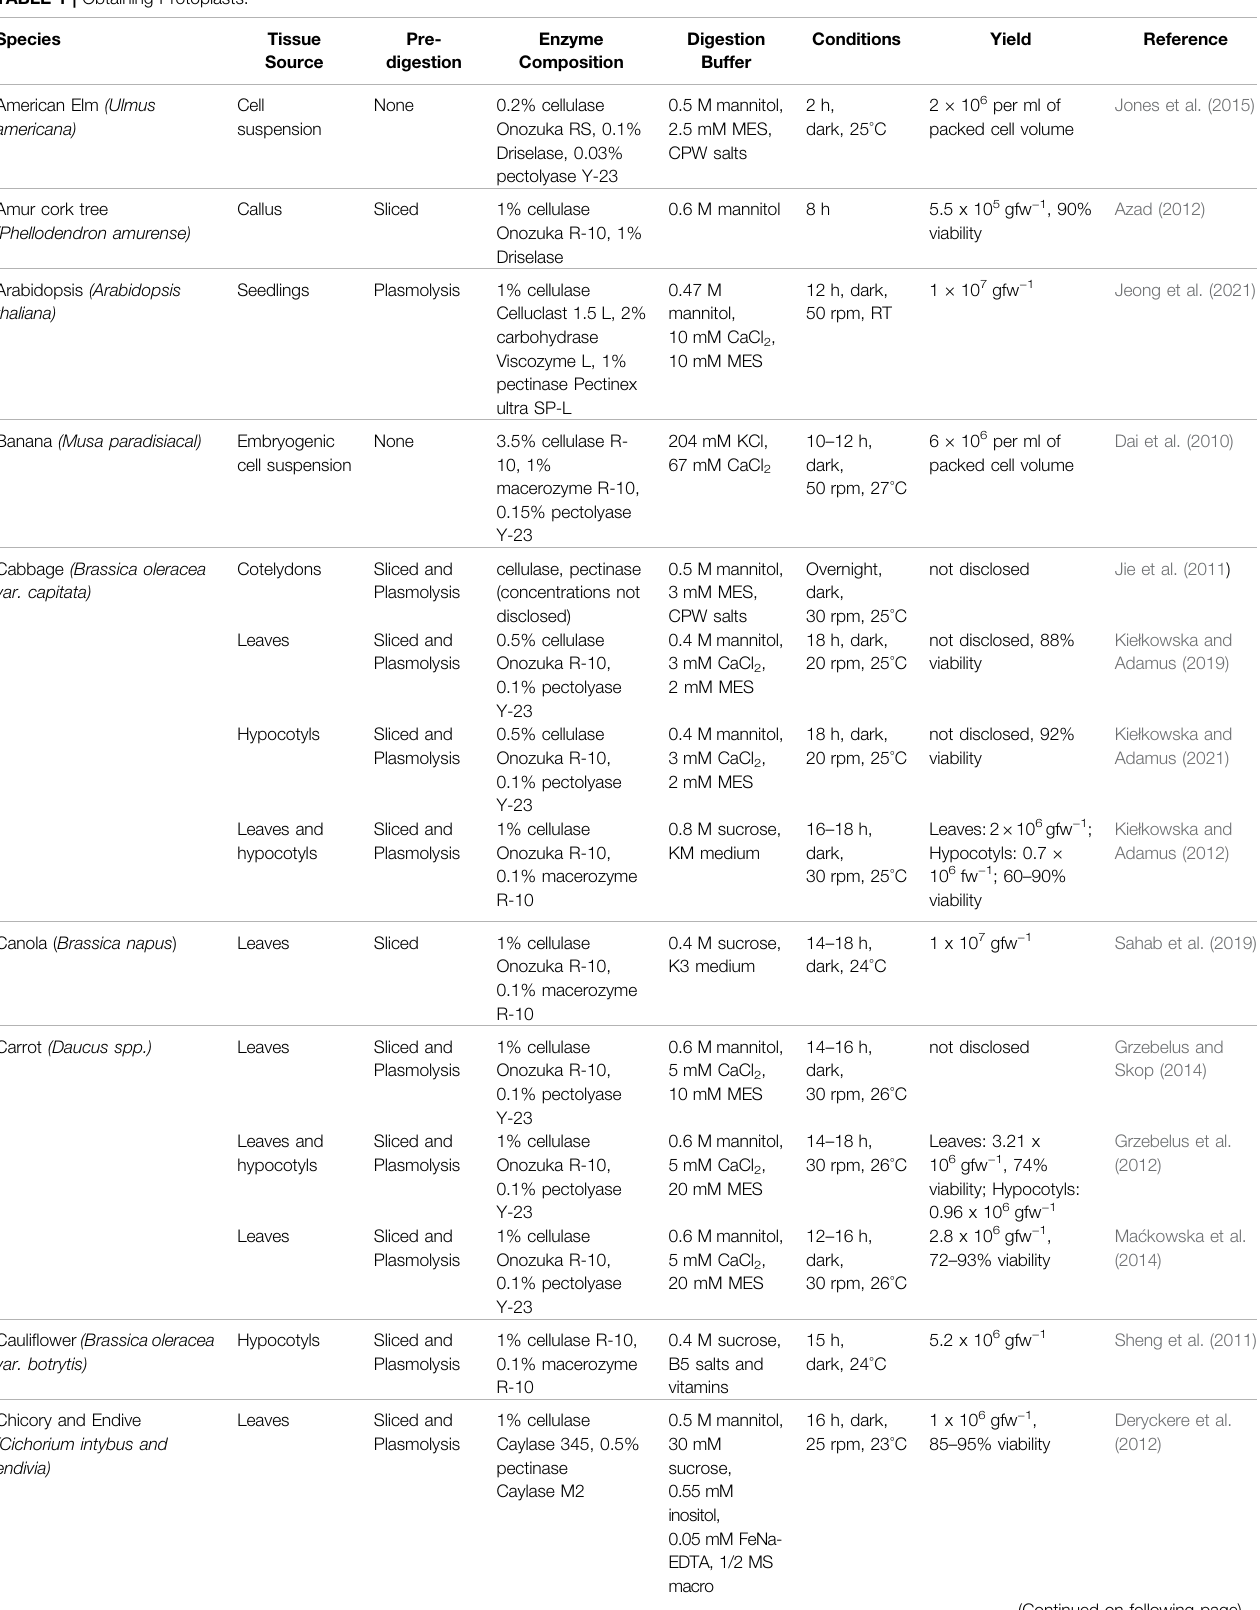
TABLE 1 | Obtaining